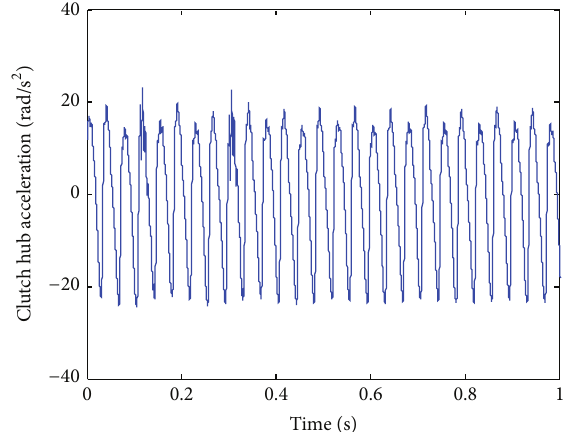
Figure 35: Angular acceleration of the clutch hub.